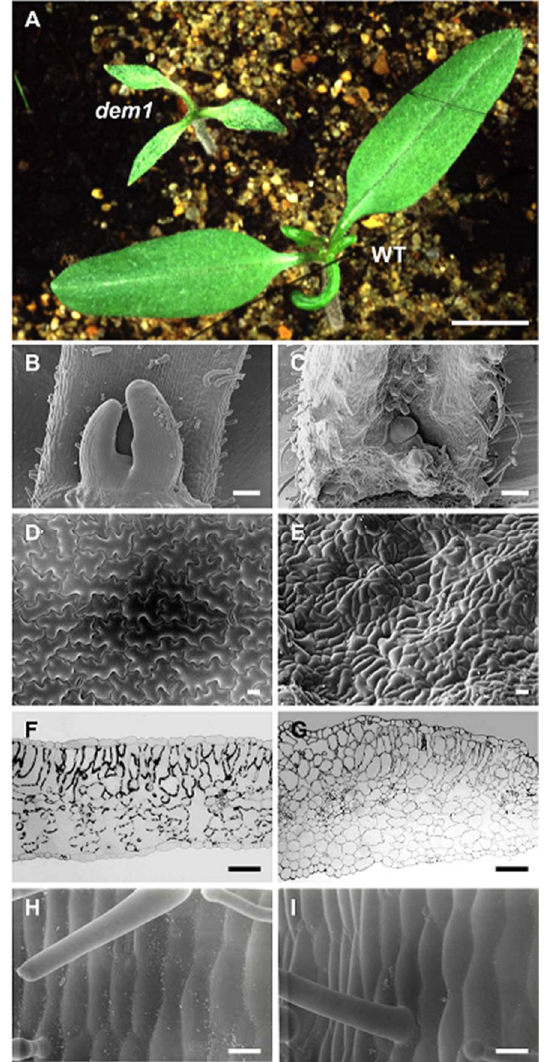
Figure 1. Phenotypes displayed by 2-week-old WT tomato and dem1 mutant seedlings. ( A ) Phe- notypes displayed by 2-week-old WT tomato and dem1 mutant seedlings. SEM of the shoot apical regions and cotyledons of a 2-week-old WT tomato ( B ) and dem1 mutant ( C ) seedling post the re- moval of one cotyledon to facilitate viewing. SEM of the adaxial epidermis of the cotyledons of WT tomato ( D ) and dem1 mutant ( E ) seedlings. Transverse sections of fully expanded cotyledons of WT tomato ( F ) and dem1 mutant ( G ) seedlings. SEM of the hypocotyl of WT tomato ( H ) and dem1 mutant ( I ) seedlings. Scale bars = 5 mm ( A ), 100 µ m ( B , C , F , G ), and 30 µ m ( D , E , H , I Transverse sections of WT tomato and dem1 mutant cotyledons not only revealed that dem1 cotyledons were thicker than WT cotyledons, but that the development of the inter- nal tissues of cotyledons was greatly altered by mutation of the SlDEM1 locus (Figure 1F,G). Figure 1F shows that the photosynthetically competent palisade mesophyll is com- posed of a loosely packed row of columnar cells aligned beneath the adaxial epidermis, below which a layer of largely spherical spongy mesophyll cells interspersed with numer- ous airspaces make up the abaxial (lower) half of the internal tissue of a WT cotyledon. In contrast, the palisade mesophyll of dem1 cotyledons was revealed to be highly disor- ganized, being composed of multiple layers of variously sized cells (Figure 1G). In addi- tion, although the spongy mesophyll of the abaxial half of a dem1 cotyledon is composed of roughly evenly sized cells, the proliferation of spongy mesophyll cells was enhanced. This led to the expansion of spongy mesophyll cells into the adaxial half of dem1 cotyle- dons, which in turn, greatly reduced the number of airspaces that formed in the lower half